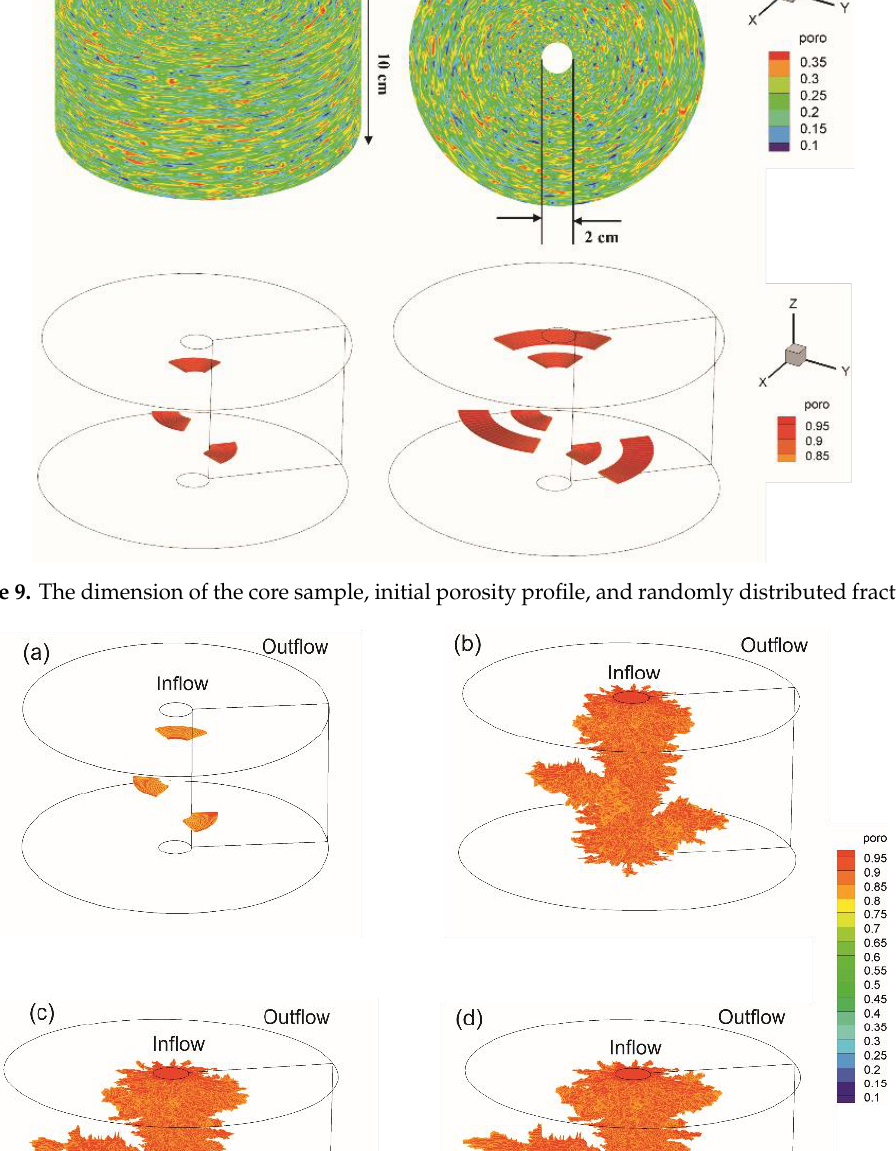
Figure 10. Temporal and spatial evolution of porosity. ( a ) initial condition; ( b ) 14.4 min; ( c ) 28.8 min; ( d ) 48 min (breakthrough).